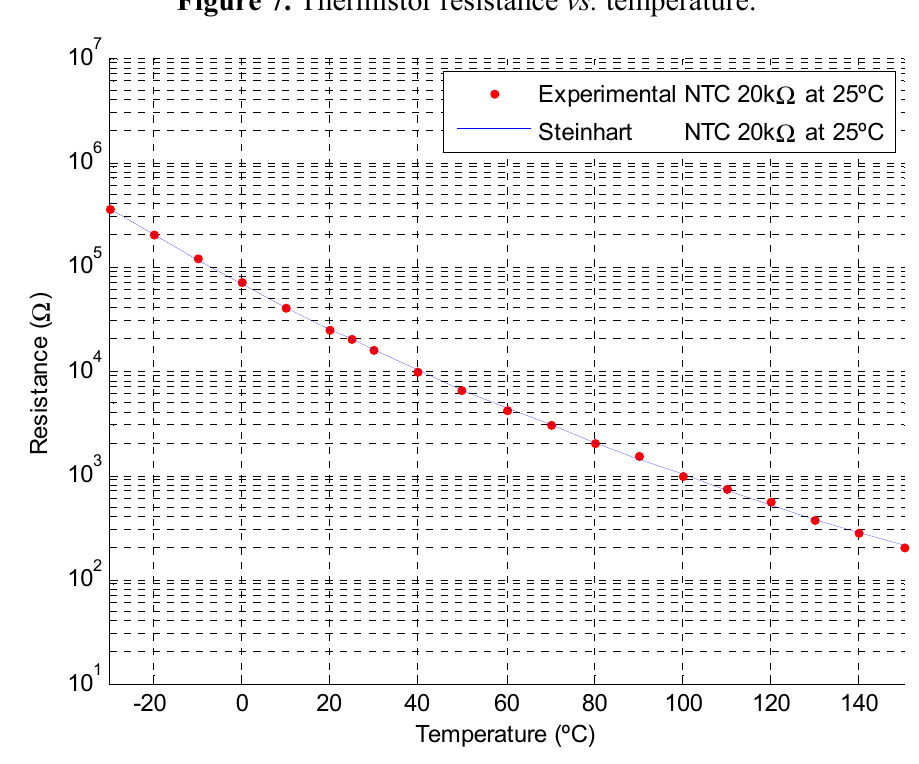
Figure 7. Thermistor resistance vs.